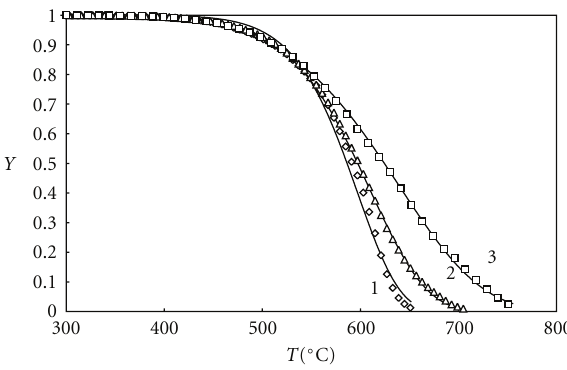
Figure 3: TGA thermograms at the heating rate of 10 ◦ /min for arrays of the initial PDI of 1.14 (1), 2 (2), and 3 (3). Points show values obtained by simulation, and continuous lines show treatment results by the nonlinear regression method. Table 3: Estimations of the Avrami equation parameters for arrays with di ff erent initial PDI under dynamic TGA mode of